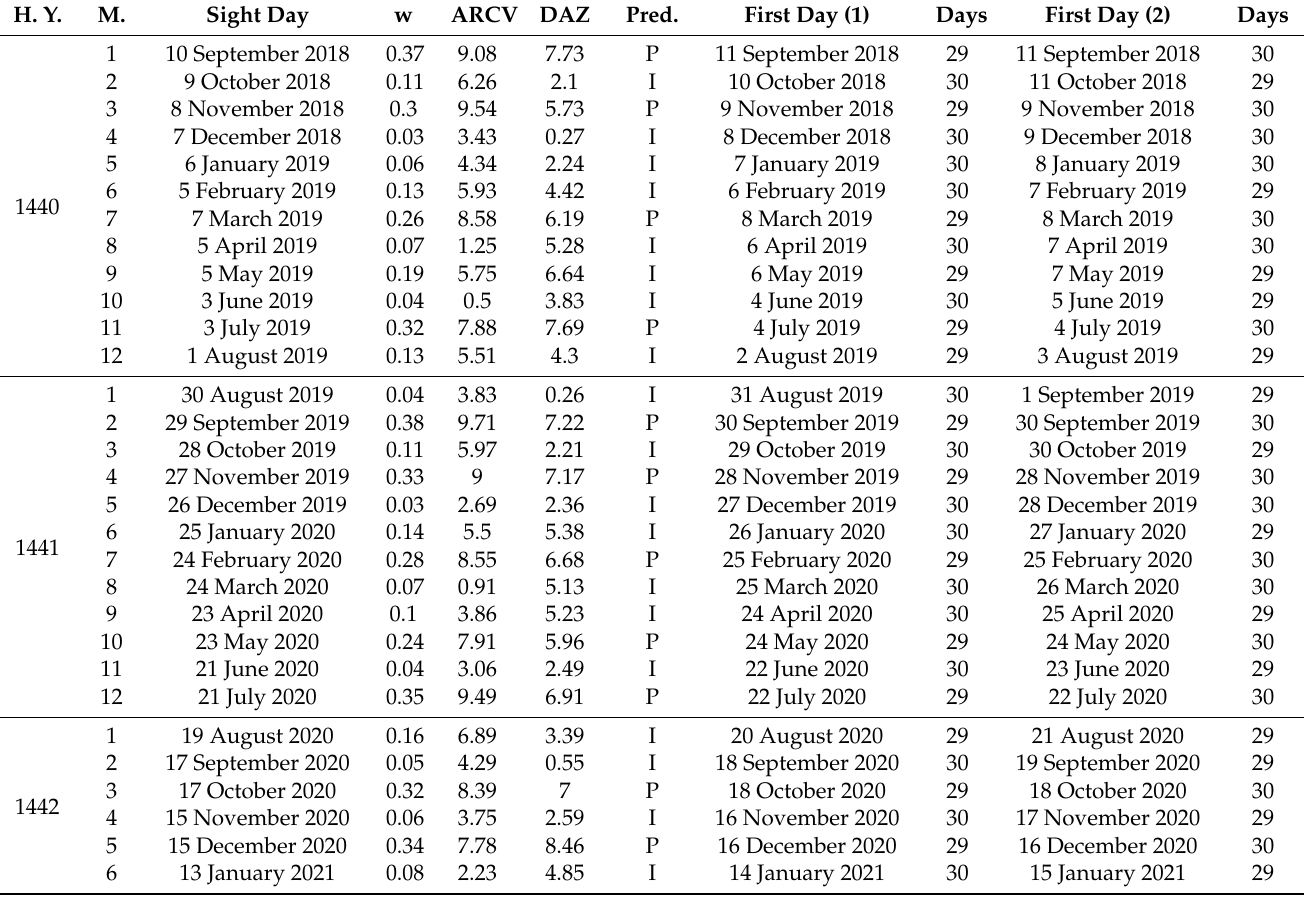
Table 6. The first days of the Hijri lunar months of the years (1440–1443) in astronomical (1) and observational (2) methods. The difference appear only when the moon is “Invisible” on sight day. H.